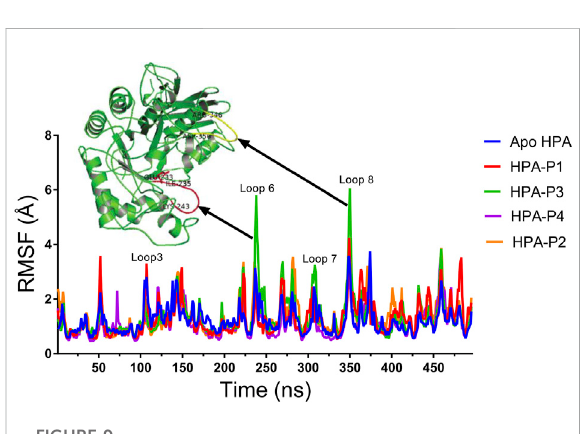
FIGURE 10 Effects of P1 (marsectohexol) from Gongronema latifolium andacarboseonthebloodglucoselevelaftertheadministrationof 3 mg/kgstarchtoalbinorats.Valuesarethemean±SEM( n =4),at p <